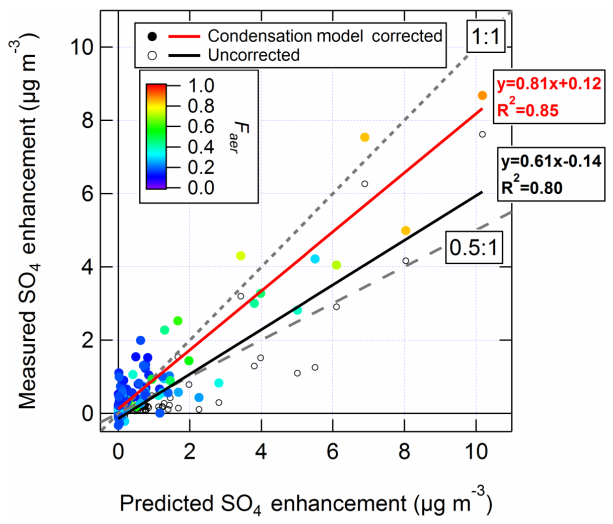
Figure 6. Measured vs. predicted SO 4 formation after OH oxidation in an OFR. The data points are colored by the fraction of H 2 SO 4 predicted to condense on aerosols, calculated using α = 0 . 65 and the average of the SMPS size distributions measured before and after oxidation. Data are shown with the LVOC fate correction ap- plied, along with linear fits to the corrected (red) and uncorrected (black) data. Ambient SO 2 concentrations <0.2ppb have been ex- cluded from this